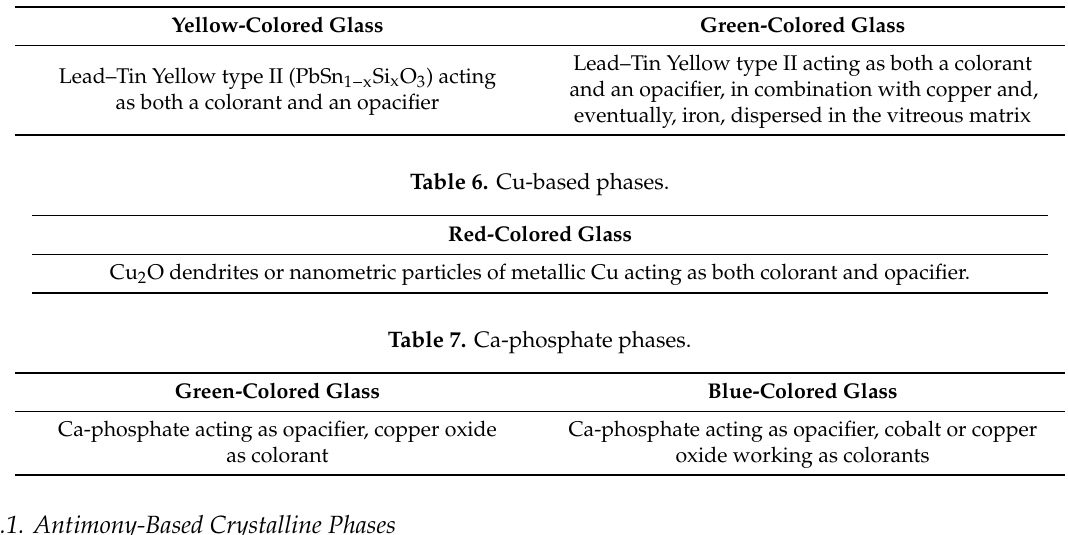
Table 5. Lead–tin-based phases.